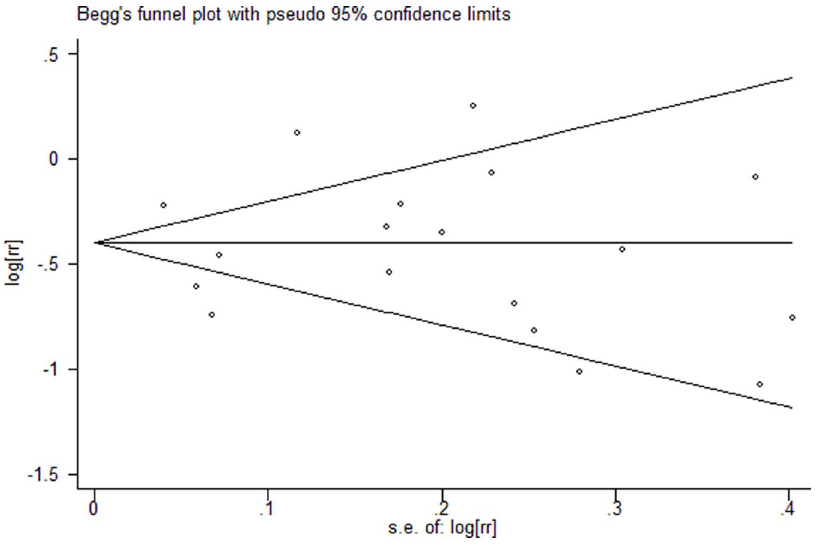
Figure 4. Begg ’ s funnel plot did not identify substantial asymmetry in the meta-analysis of total 15 studies.